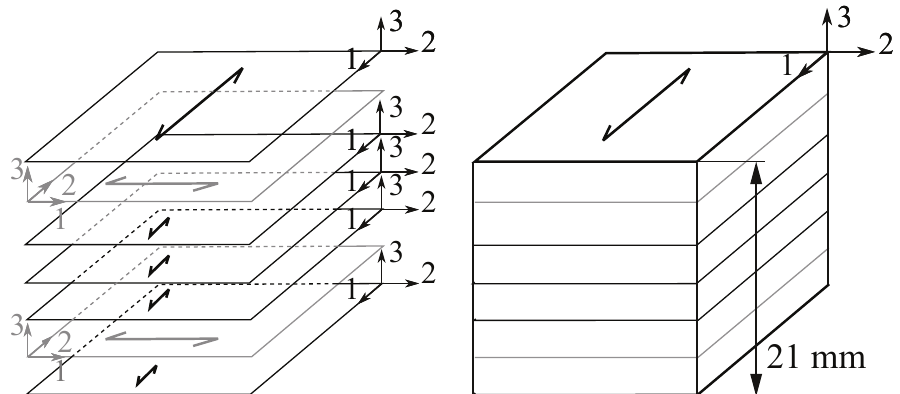
Figure 7. Material orientation of LVL panels; individual spruce veneer laminate layers ( left ) and the composed panel ( right